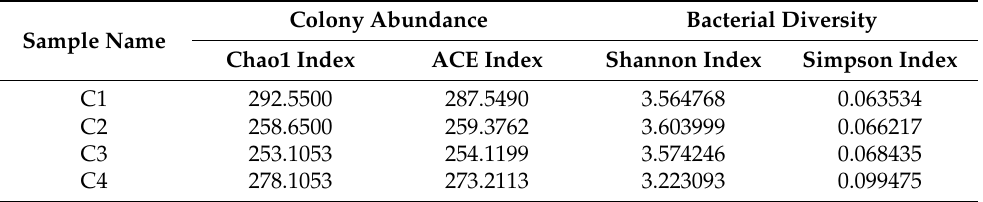
Table 3. Alpha diversity analysis based on the diversity indices of microbial operational taxo- nomic units.